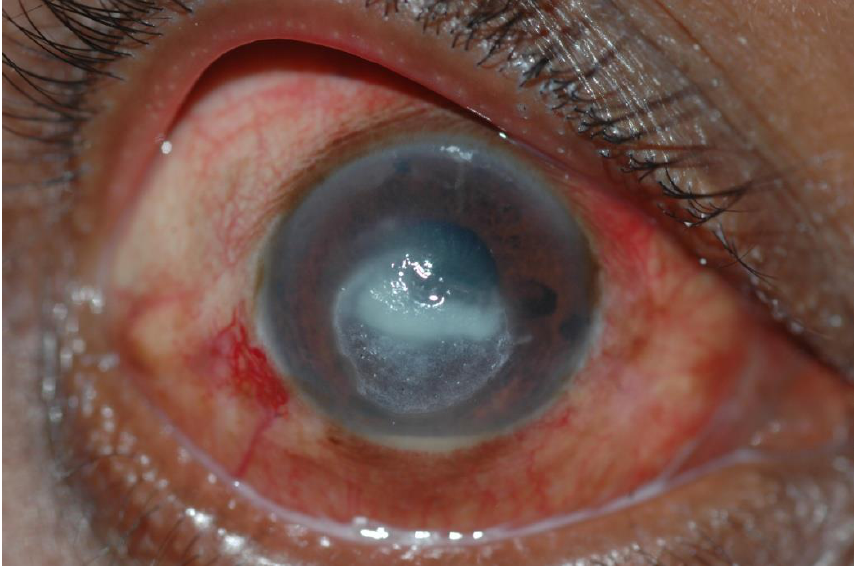
Figure 1. Corneal ulcer caused by Fusarium spp. at first presentation. Source: Mycotic Ulcer Treatment Trial, Aravind Eye Hospital, Tamil Nadu, India.